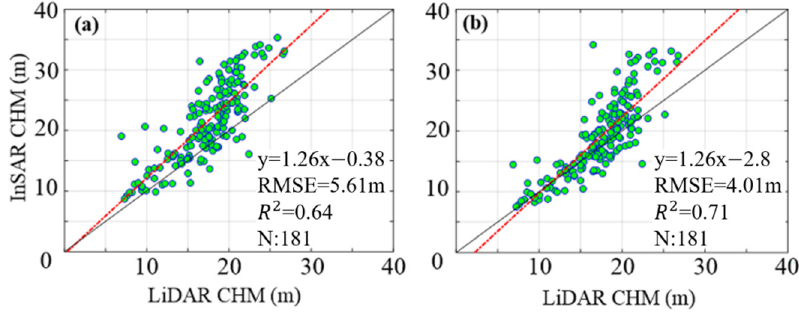
Figure 11. CHM estimated by InSAR versus LiDAR-derived CHM based on: ( a ) the TF-RVoG model; and ( b ) the TF-RVoG model with a limited extinction coefficient.